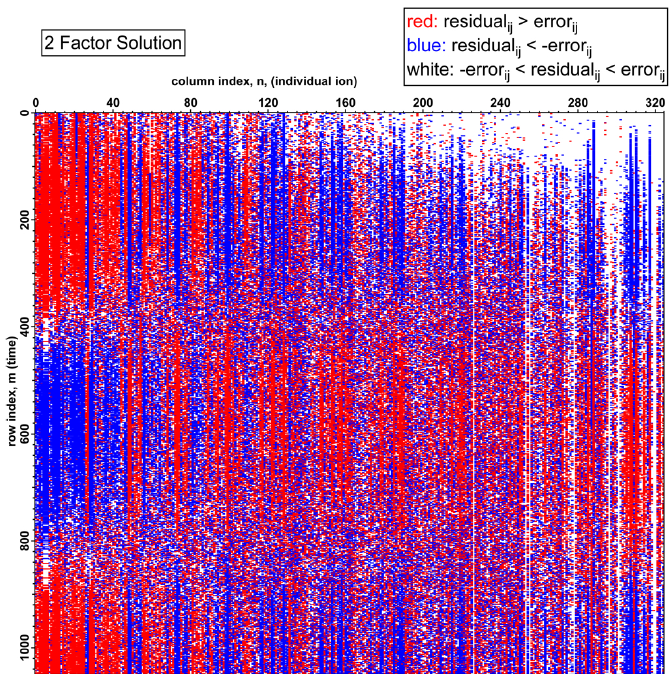
Fig. A5. The map plot for the two factor solution displays a red dot where the residual ij > error ij , a blue dot where residual ij < − error ij , and a white dot where − error ij < residual ij < error ij . For a two-factor solution there is clearly a non-random pattern, indicating two factors do not adequately describe the data.